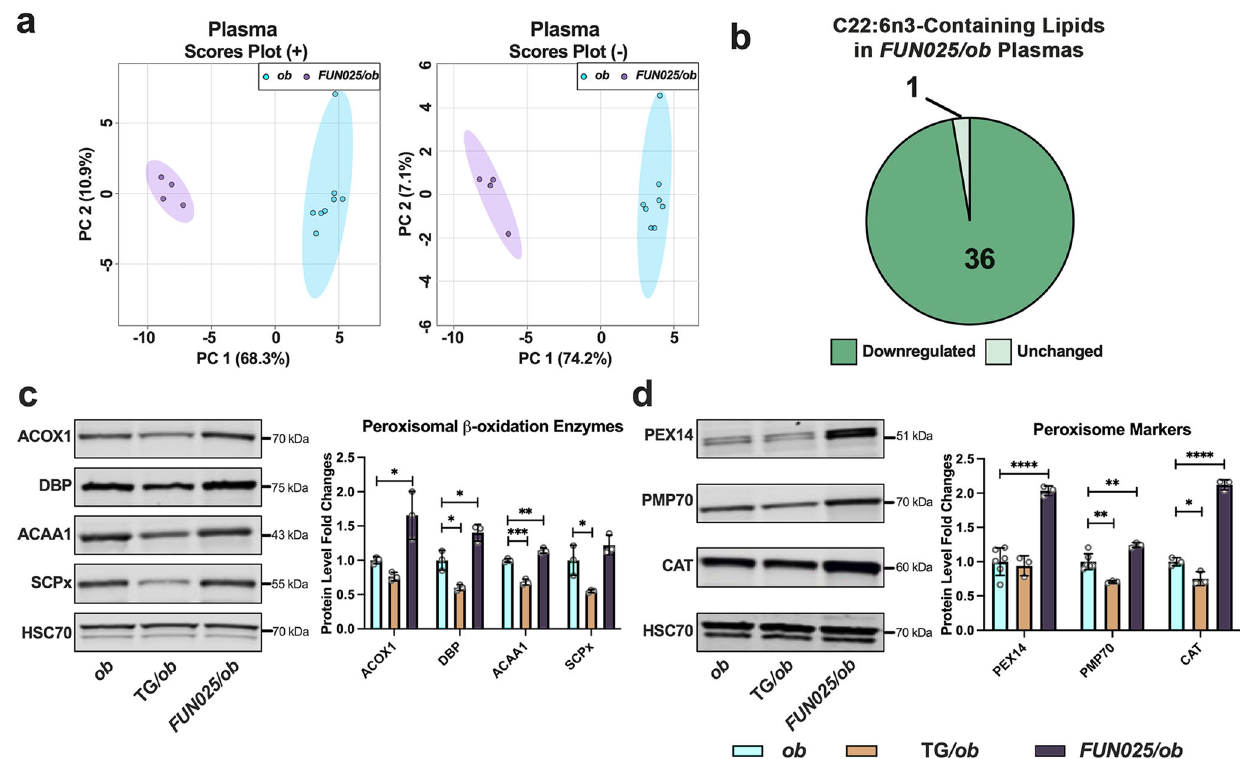
Fig. 9 Tmem135 mutation decreases docosahexaenoic polyunsaturated fatty acid-containing lipids and increases peroxisomal proteins in leptin mutant mice. a Principal component analysis of lipids detected in the positive ( + ) ion mode and negative ( – ) ion mode of 3-month-old male Lep ob/ob ( ob ) ( N = 8) and Tmem135 FUN025/FUN025 / Lep ob/ob ( FUN025/ob ) ( N = 4) plasmas based on log10 concentrations. b Pie graph of docosahexaenoic acid (DHA, C22:6n3)- containing lipids that were signi fi cantly downregulated (medium green) and unchanged (light green) in Tmem135 FUN025/FUN025 / Lep ob/ob plasmas compared to Lep ob/ob . Numbers denote the total of lipids within the category. All altered lipid species including DHA-containing lipids can be found in Supplementary Table 10. Signi fi cance was determined by two-way Student ’ s t test ( P < 0.05). c Western blot analysis of peroxisomal beta-oxidation enzymes including acyl-CoA oxidase 1 (ACOX1), D-bifunctional protein (DBP), acetyl-Coenzyme A acyltransferase 1 (ACAA1), and sterol carrier protein x (SCPx) using liver lysates from 3-month-old male Lep ob/ob ( N = 3), Tmem135 TG/ Lep ob/ob (TG/ ob ) ( N = 3) and Tmem135 FUN025/FUN025 / Lep ob/ob ( N = 3) mice. d Western blot analysis of peroxisome biogenesis factor 14 (PEX14), peroxisome membrane protein 70 (PMP70), and catalase (CAT) using livers from 3-month-old male Lep ob/ob ( N = 3 – 6), Tmem135 TG/ Lep ob/ob ( N = 3) and Tmem135 FUN025/FUN025 / Lep ob/ob ( N = 3) mice. HSC70 served as the loading control for these experiments. Asterisks (*, **, ***, and ****) indicates post hoc Tukey test for a P < 0.05, P < 0.01, P < 0.001, and P < 0.0001 signi fi cance following a signi fi cant difference detected by one-way ANOVA. Dots represent individual data points. The protein size next to the immunoblot images denotes the size of the immunoband measured for this analysis. Data are presented as mean ±